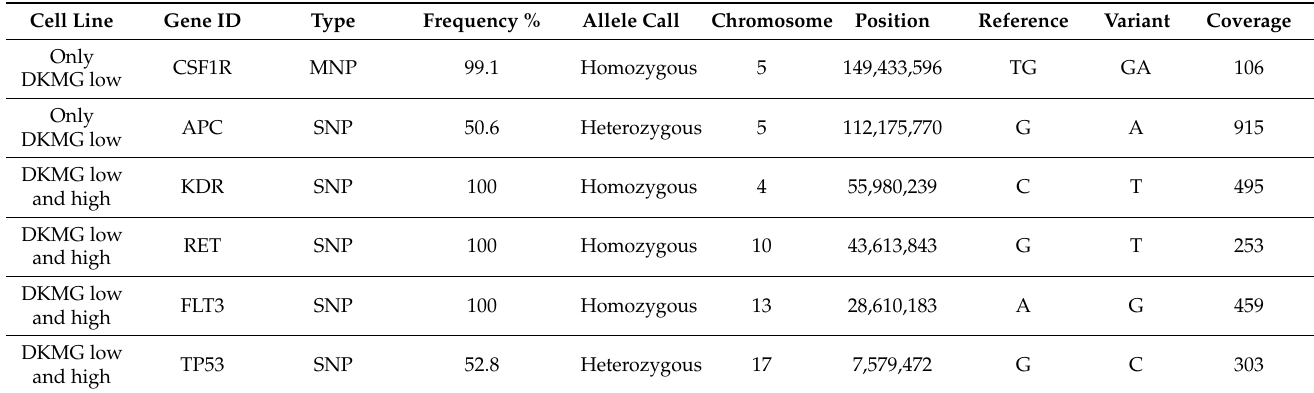
Table 1. NGS analysis of DK-MG sublines. Novel mutations detected by Ion Torrent™ Personal Genome Machine sequencing in DK-MG low and DK-MG -high sublines, which had not been previously published in the Cancer Cell Line